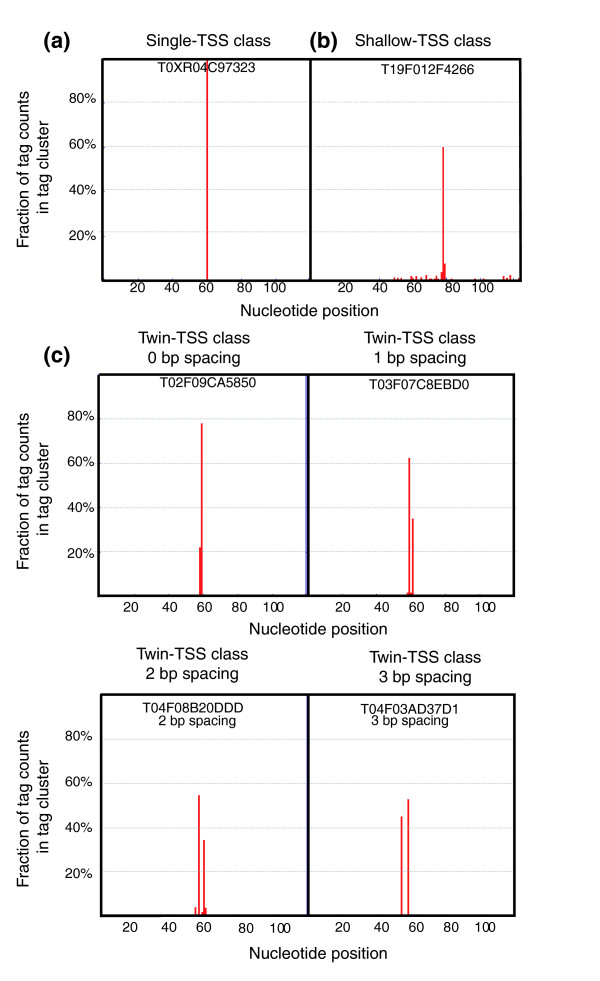
Representative examples of subclasses of SP promoters. Histograms show the fraction of tags that map into the 120 bp region centered on the TC. TC identifiers are shown above each histogram. Three subclasses of the SP TCs defined by Carninci and coworkers [8] were analyzed: (a) single-TSS promoters having a single well defined TSS; (b) shallow-TSS promoters, which is the subset of single TSS promoters that have one sharp peak surrounded by multiple weakly defined TSSs; and (c) twin-TSS classed promoters, which are characterized by two closely located, well defined TSSs, and in turn can be classified by the number of base pairs in between them (0-3 bp spacing). bp, base pair; SP, single peak; TC, tag cluster; TSS, transcription start site.